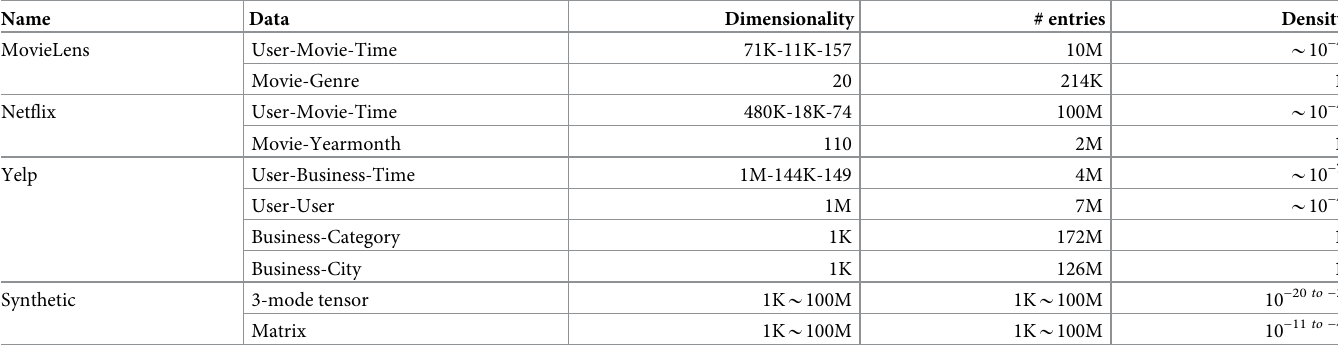
Table 4. Summary of the data used for experiments. ‘K’ means thousand, and ‘M’ million. Tensors and matrices of density 1 are fully